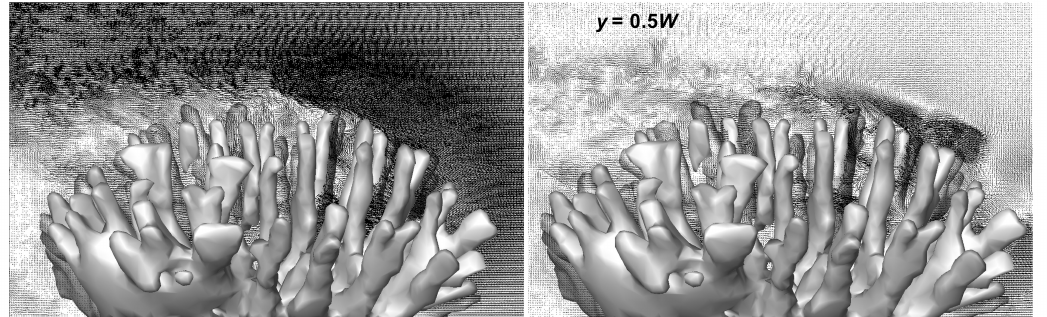
Figure 10. Side view of instantaneous mean ( left ) and fluctuating ( right ) velocity vector components above P. eydouxi at y = 0.5 W , where W is the width of the colony. Here, the flow is moving from right to left. The instantaneous mean vector field ( left ) shows a higher concentration of velocity vectors above the colony as most of the flow is diverted to the top and sides of the colony. The fluctuating vector field was obtained by subtracting mean velocity from the instantaneous velocity field. These fluctuating velocity components also appear denser at the top surface of colony and contribute, to the Reynolds stress which controls mass transport to and from the top surface of the